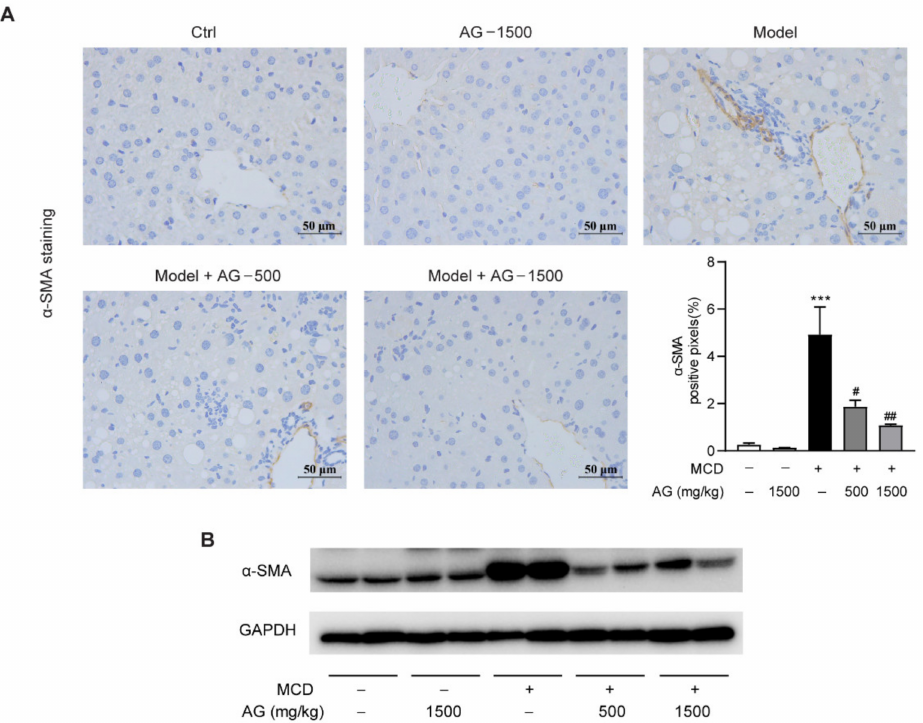
Figure 6. Ala-Gln suppressed hepatic stellate cells activation in MCD-fed mice. ( A ) Representative images for α -SMA staining ( × 400) in the liver section and quantitative results. ( B ) Hepatic α -SMA protein levels. Data are expressed as the mean ± SEM. *** p < 0.001, compared to the Ctrl group; # p < 0.05, ## p < 0.01, compared to the Model